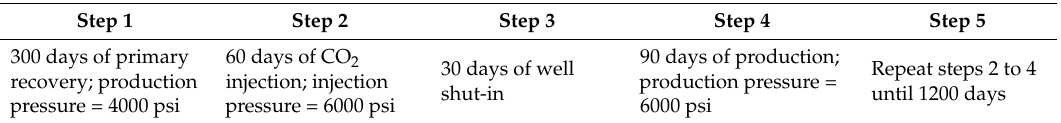
Table 4. CO 2 huff-and-puff steps.